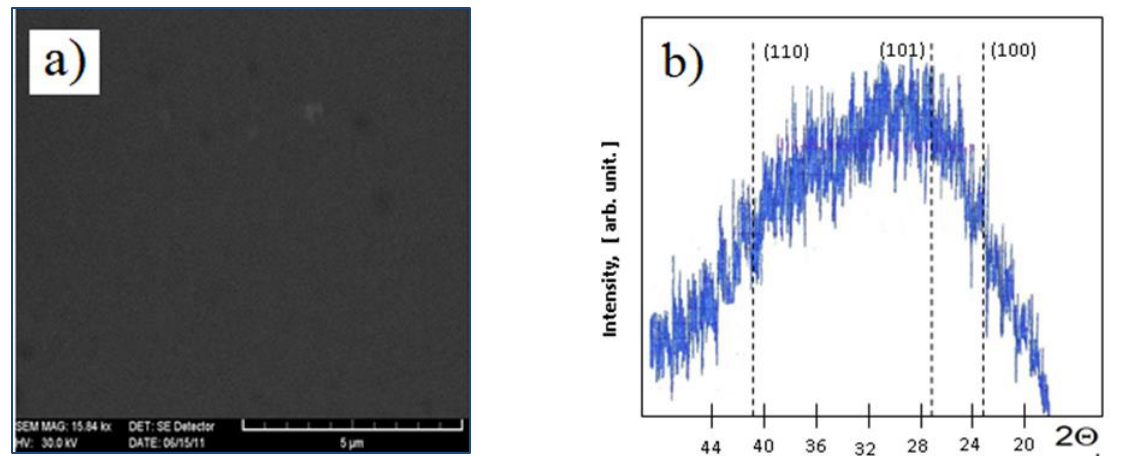
Figure 2. a) SEM micrographs and b) XRD diffraction pattern of Te films grown on Pyrex glass substrates with a deposition rate